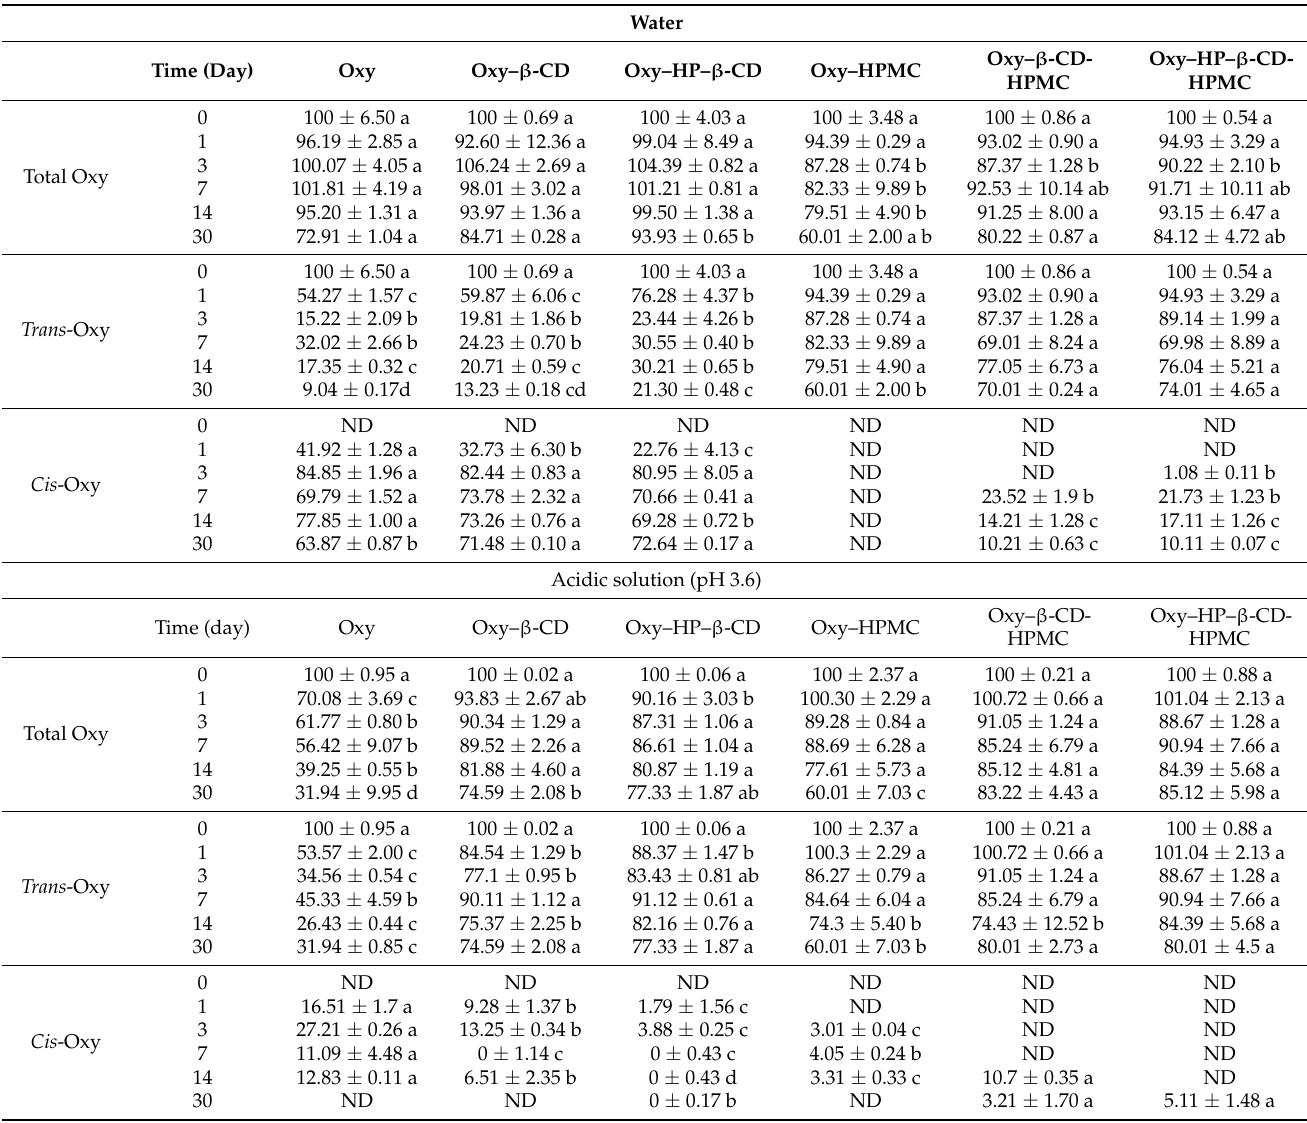
Table 2. The percentage of remaining Oxy (total Oxy, trans - and cis -forms) in Oxy,